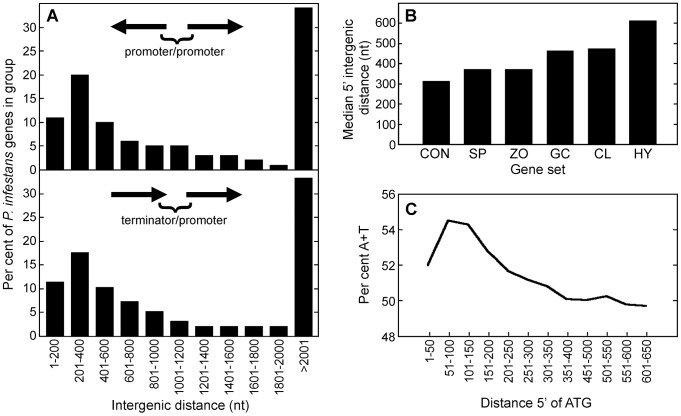
Characteristics of promoters in P. infestans.
(A) Intergenic distances between genes oriented 5′ to 5′ and 3′ to 5′ are shown in the top and bottom graphs, respectively. Values are based on 15,471 genes from the largest P. infestans supercontigs. (B) Median 5′ intergenic distances in genes with different patterns of expression, based on the subset of genes having intergenic distances <2 kb. As described in Results, these were from constitutively expressed genes (CON), or those induced >7.5-fold in sporangia (SP), swimming zoospores (ZO), germinated cysts (GC), cleaving sporangia (CL), or hyphae (HY). (C) A+T content of DNA upstream of start codons, calculated in 50-nt bins. Little change was observed further upstream.